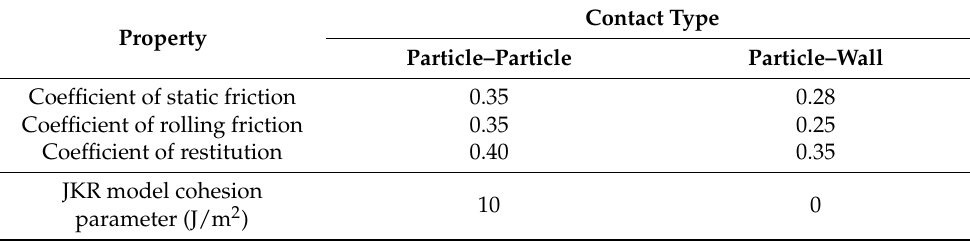
Table 4. Summary of contact parameters used in the simulations.